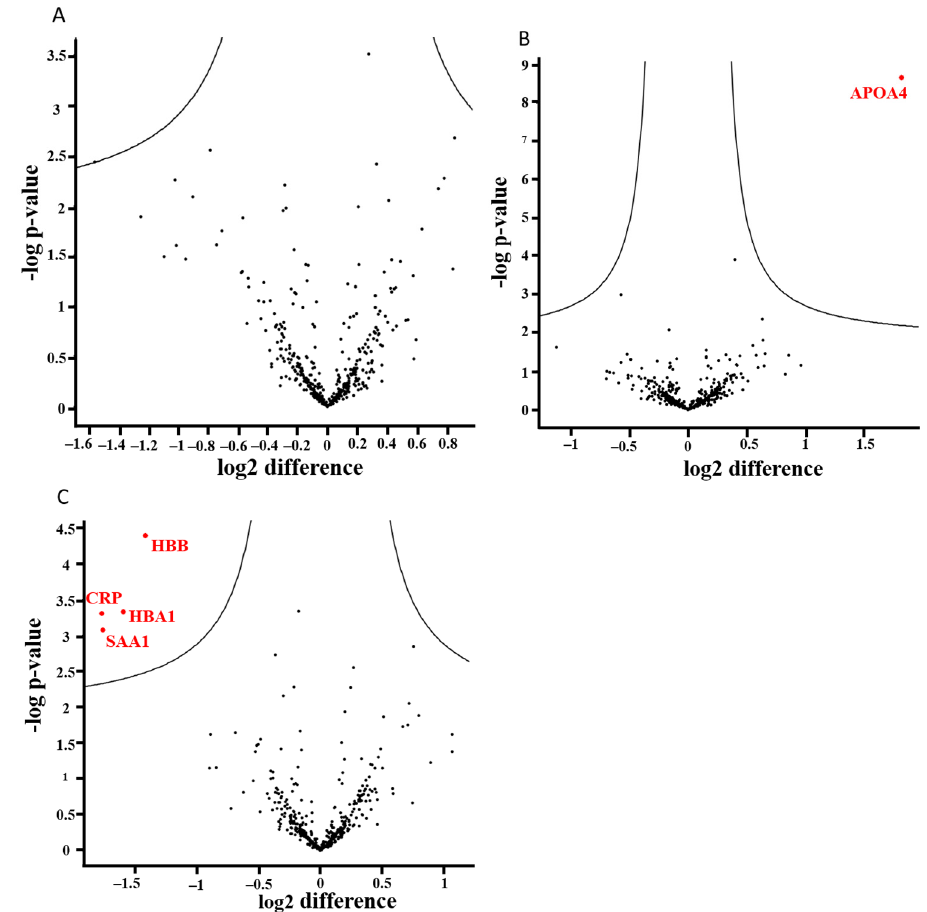
Figure 4. ( A – C ). Results of proteomic analyses with plasma samples of the BS patients ( n = 35): 410 proteins and 3182 peptides were analyzed. The distribution of up- and downregulated proteins is shown in volcano plots. For each identified protein, the fold-changes were plotted on a logarithmic scale to the basis of 2 (ln2 Δ t-test), and the corresponding p -values ( − log p -value) for individual proteins are indicated.